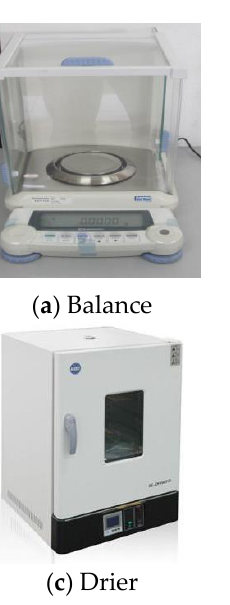
Figure 5. Typical tools used in experiments.